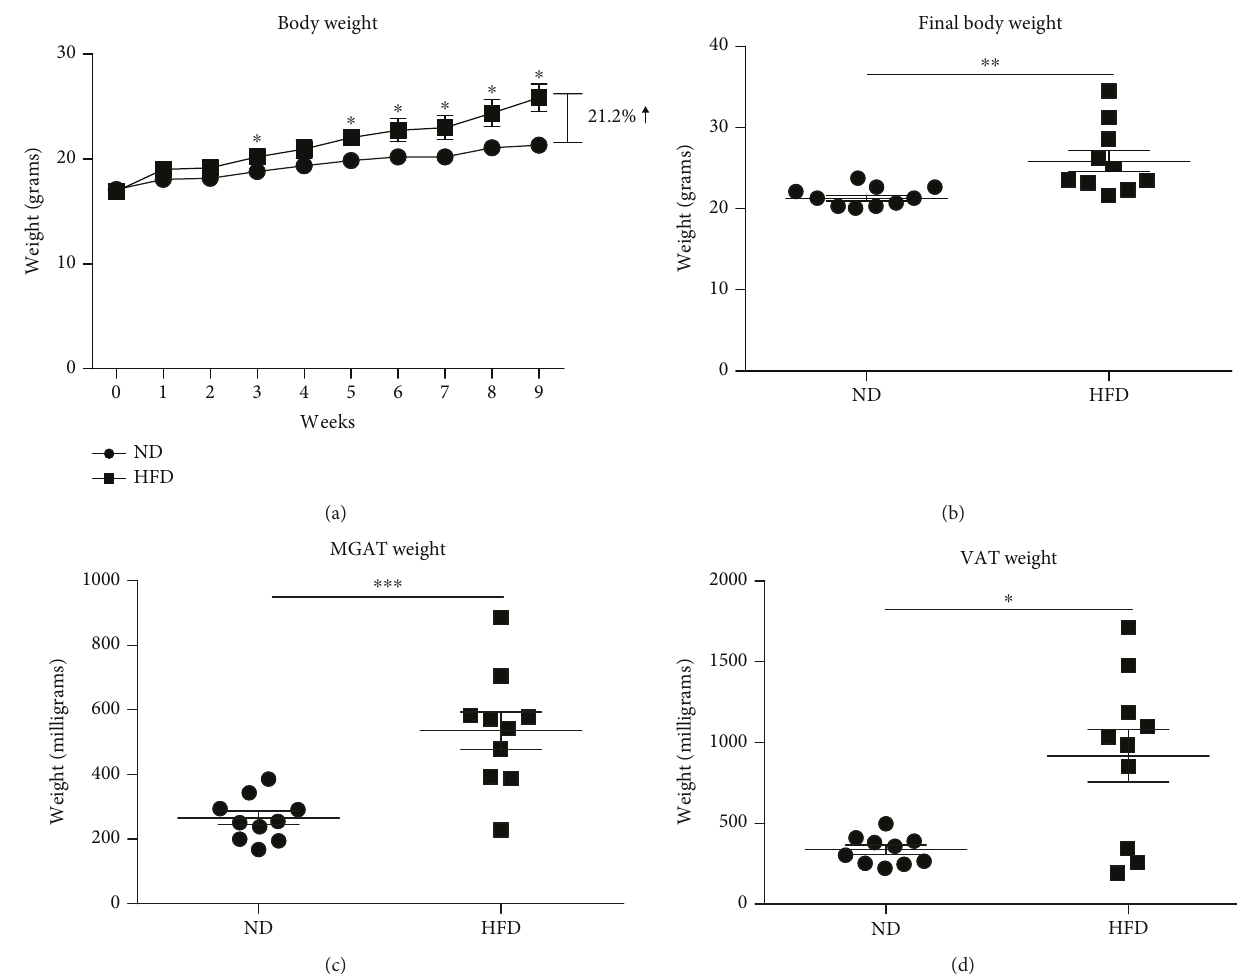
Figure 1: Increased overall body weight and adipose tissue in mice fed with a high-fat diet for 9 weeks compared to lean mice. (a) Total body weight of female C57BL/6 mice fed with a high-fat diet (HFD, 60% · kcal from milkfat) or normal diet (ND) over 9 weeks. (b) Graphical representation of total body weight of HFD- or ND-fed mice at endpoint, when HFD-fed mice reached a ~ 20% increase in total body weight compared to ND-fed mice. (c, d) Total weight of mammary gland-associated adipose tissue (MGAT) or visceral adipose tissue (VAT) isolated from HFD- or ND-fed mice at endpoint. Data are presented as mean ± SEM of 10 mice per group. ∗ p < 0 05 , ∗∗ p < 0 01 , and ∗∗∗ p < 0 001